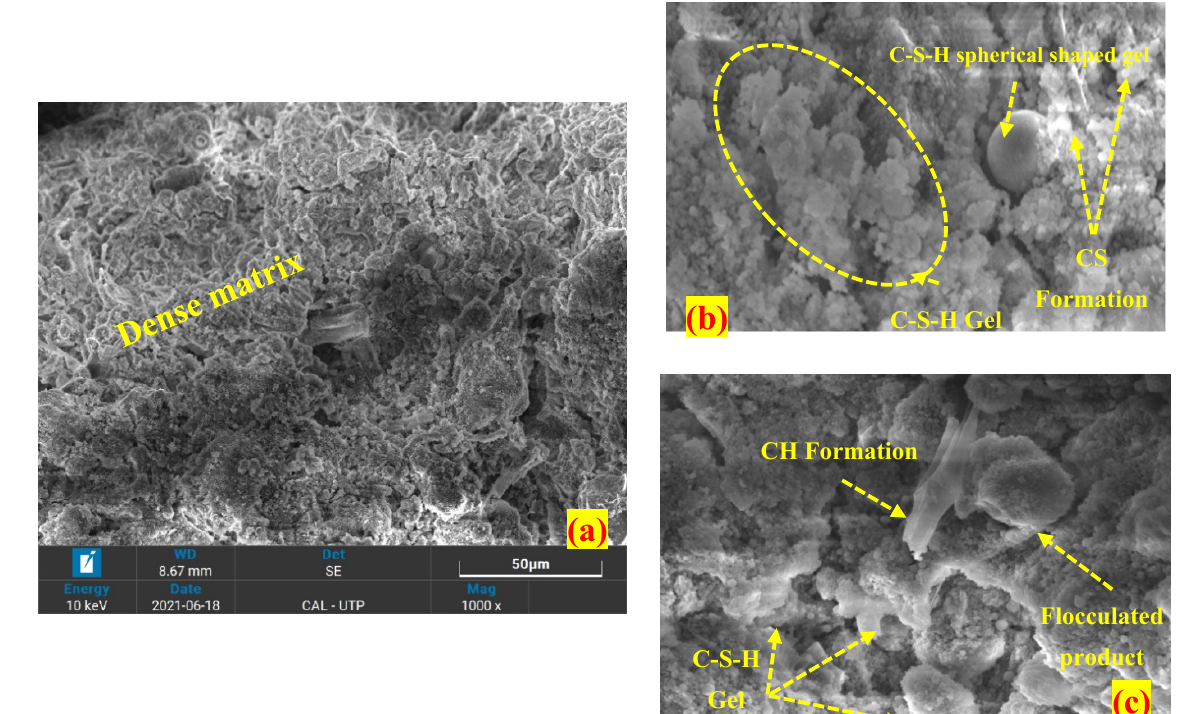
Figure 4. SEM images of 28-day cured SF stabilized peat ( a ) 1000×, ( b ) 8000×, ( c ) 10,000×.